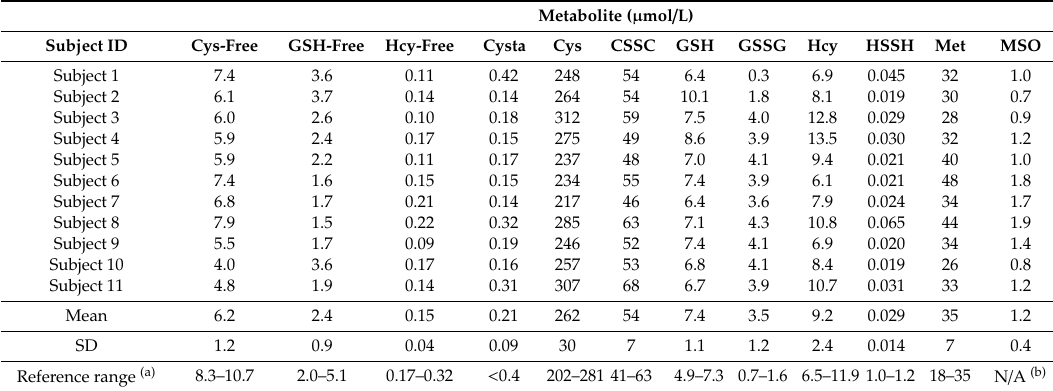
Figure 4. Thiol and thioether metabolites and relevant thiol / disulfide pools in healthy human subjects. Pools of oxidized and reduced cysteine, glutathione and homocysteine and other thiol and thioether metabolites in a cohort of 11 healthy adult subjects were determined in APS-plasma samples. As expected, Cys / CSSC represents the major thiol / disulfide pool in human plasma. Table 4. Concentration of thiol and thioether metabolites in healthy individuals ( n =